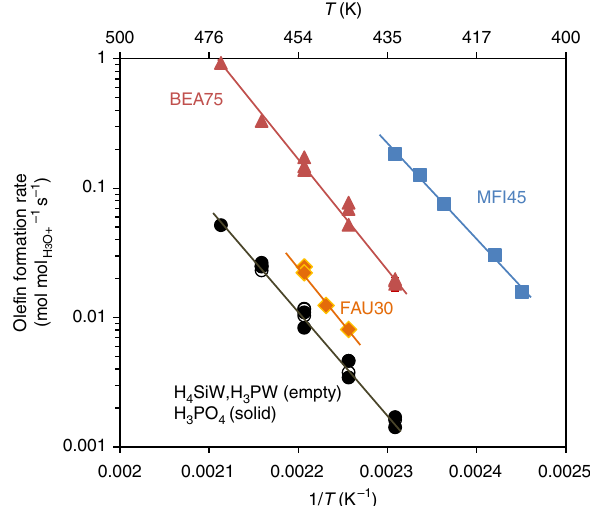
Figure 1 | Measured turnover frequencies of cyclohexene formation in aqueous-phase dehydration of cyclohexanol on different acid catalysts. For zeolites, the Si/Al ratio is denoted as the number following the framework-type code. H 4 SiW and H 3 PW stand for tungstosilicic and phosphotungstic acids. Rates were determined at conversions o 10%. Solid lines are fits to the Arrhenius equation (note that the slopes are not